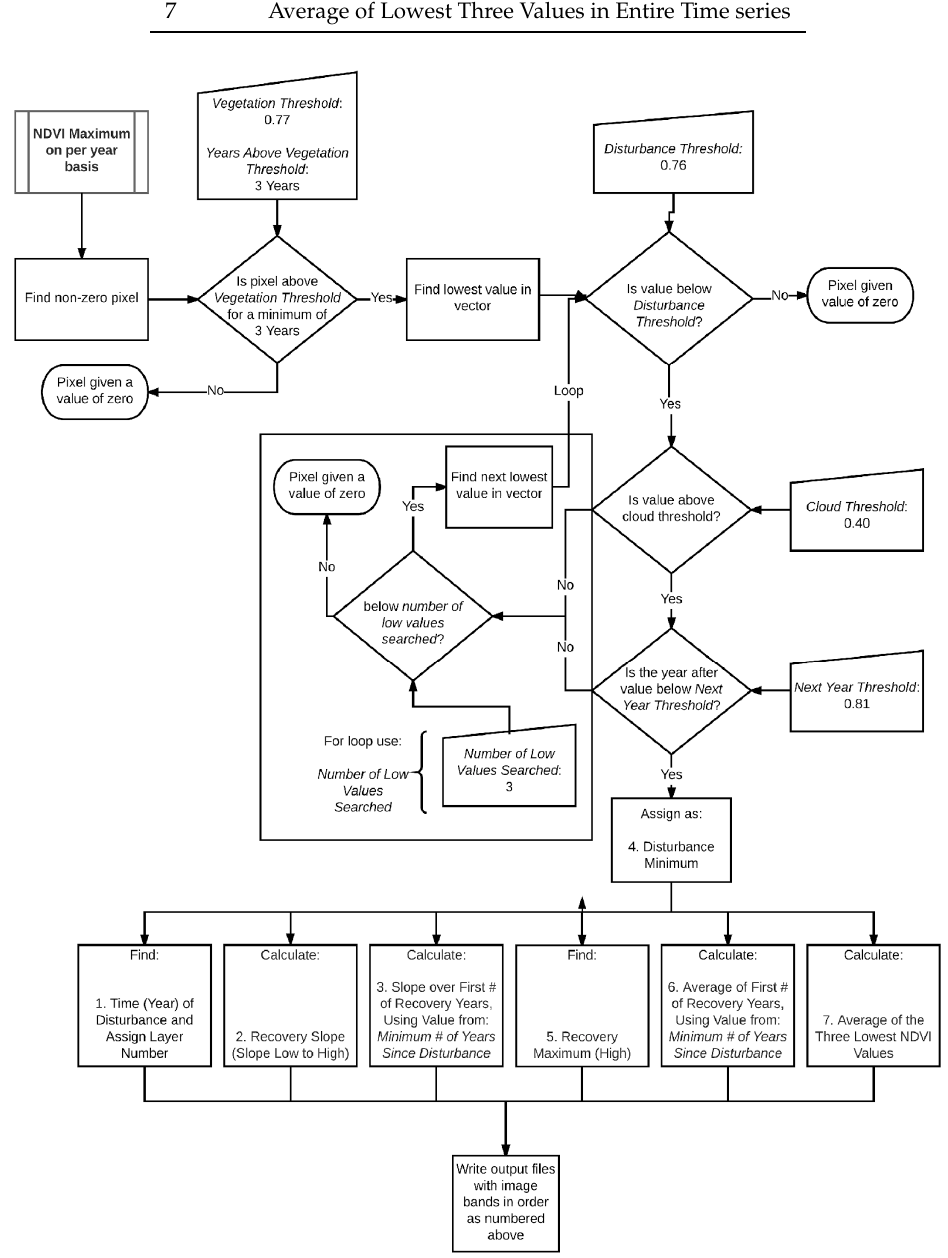
Figure A2. Flow chart of calculations within program illustrating how it identifies a given pixel as disturbed or undisturbed, and, if disturbed, what derived indices were calculated.